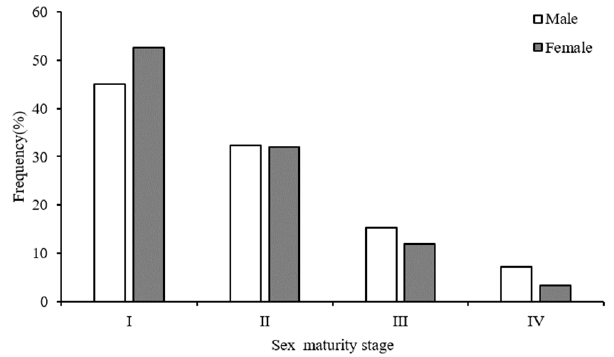
Figure 5. Maturity stage compositions of the B. magister shevtsovi by sex.